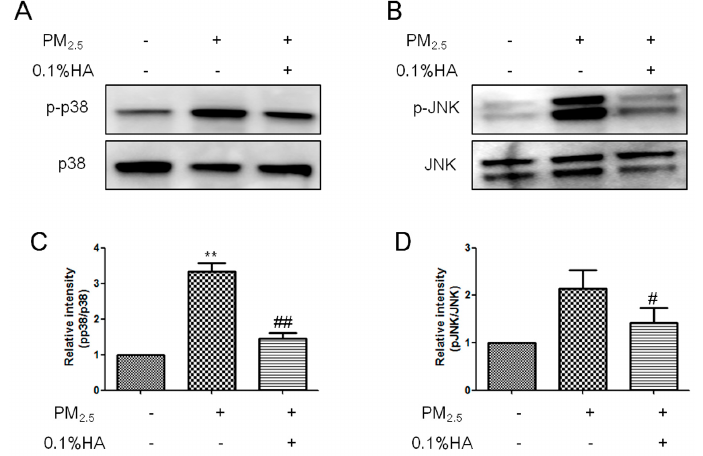
Figure 4. Effects of HMW-HA on PM 2.5 -induced JNK and p38 phosphorylation in NR8383 cells. ( A and B ) Cells were treated with PBS, PM 2.5 , or PM 2.5 and HMW-HA simultaneously for 2 h, and the protein expression of p38, p-p38, JNK, and p-JNK was determined by western blot analysis. ( C and D ) Quantitative analysis of the blots is normalized to p38 and JNK, respectively. Each bar represents mean ± SEM of three independent experiments. ** p < 0.01, compared with the group treated without PM 2.5 or HMW-HA. # p < 0.05 and ## p < 0.01, compared with cells exposed to PM 2.5